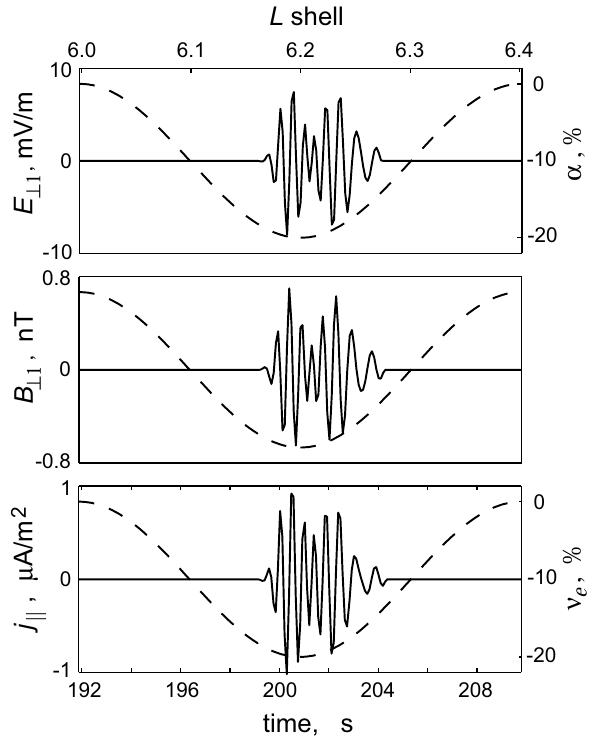
Fig. 4. Solid lines show magnitudes of E 1 ⊥ , B 1 ⊥ , and j k observed by the virtual satellite flying poleward across the computational do- main at the altitude 2500km. Dashed lines show spatial variations of α and ν e induced by the HF heater in percents of their back- ground